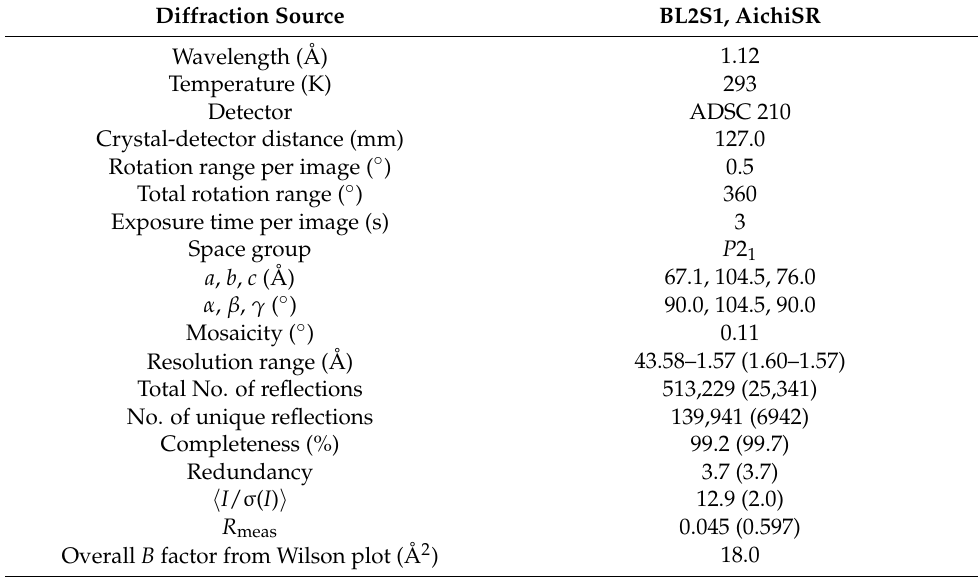
Table 6. Data collection and processing of alpha-amylase crystals.